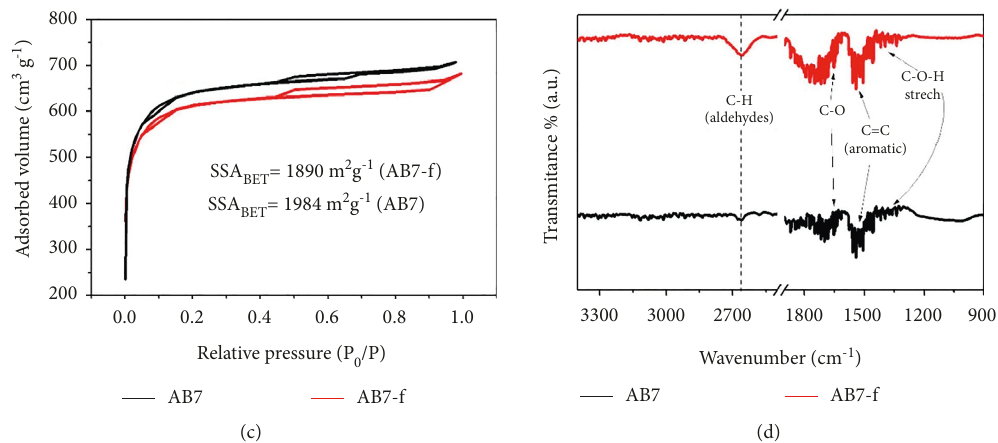
Figure 3: Structural and textural features of the catalysts. Raman spectroscopy of (a) AB7 and (b) AB7-f, (c) adsorption/desorption isotherms, and (d) Fourier-transform infrared spectra of the